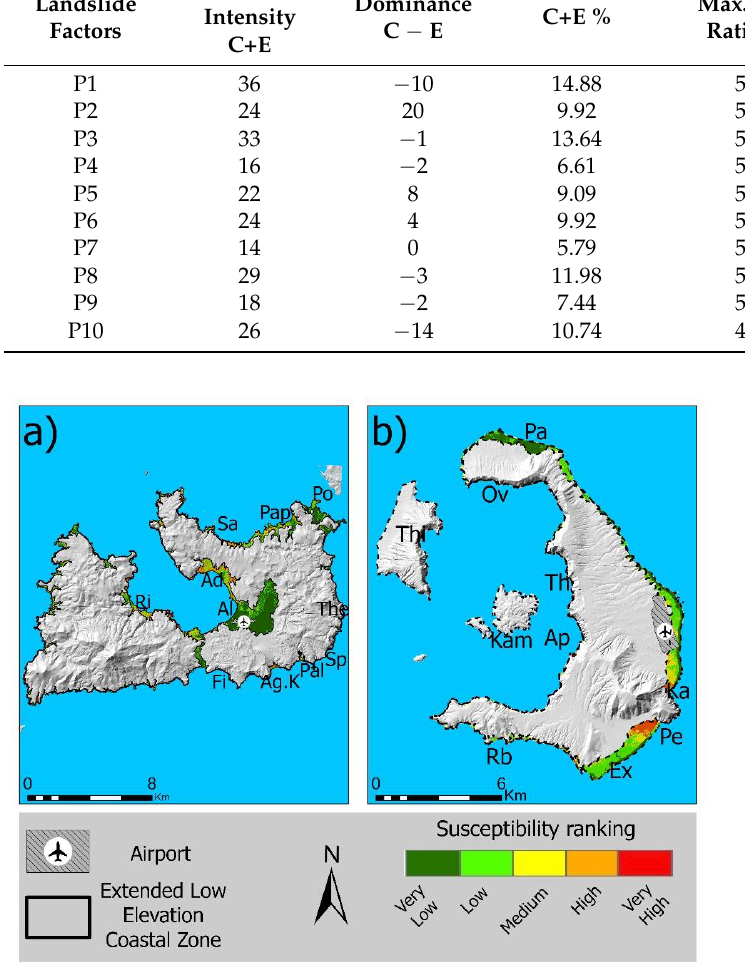
Figure 6. Landslide susceptibility maps for Milos ( a ) and Thira ( b ) islands. Table 6. Percentages of susceptibility classes to landslides in Milos and Thira islands. Very Low